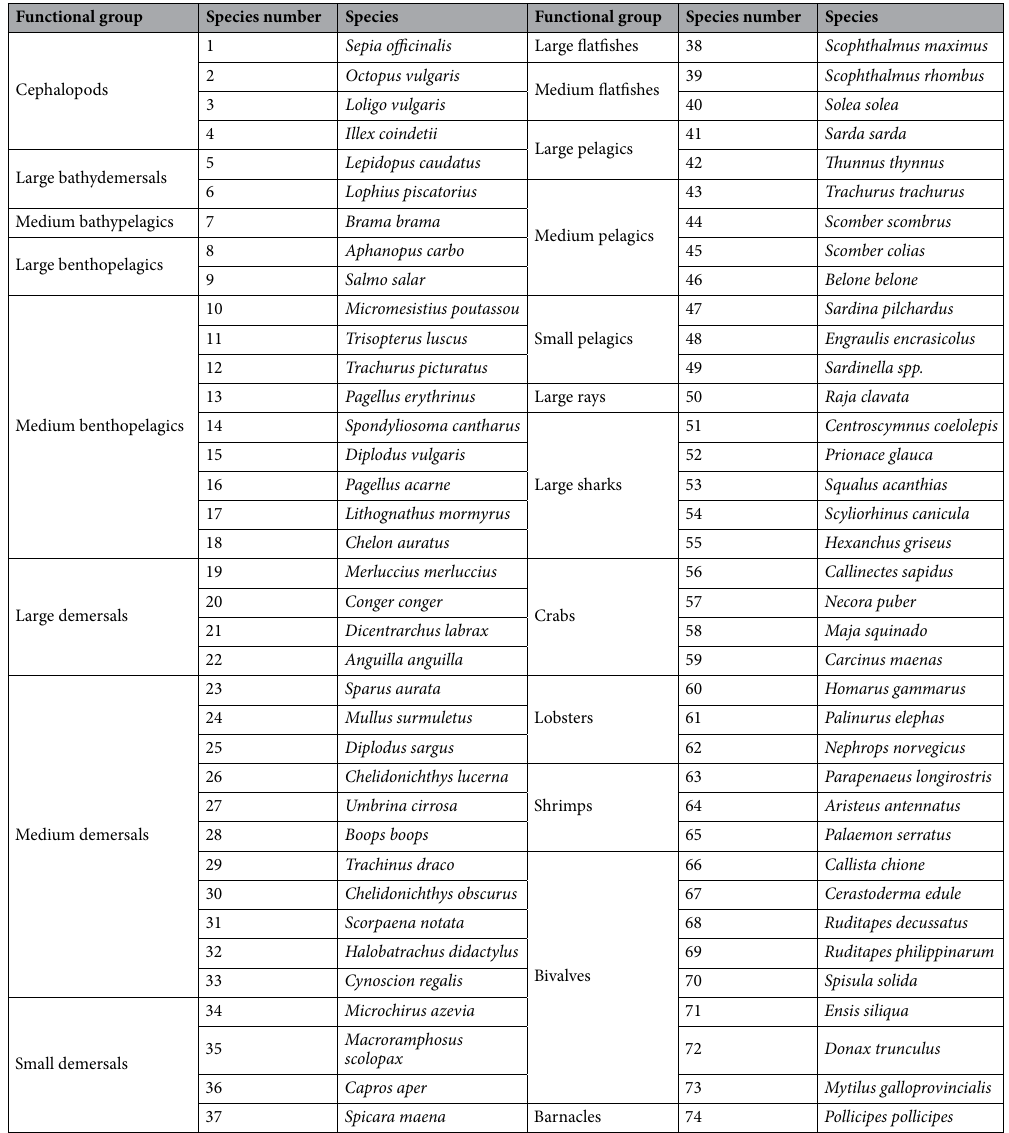
Table 1. Species and functional groups considered during the climate change vulnerability